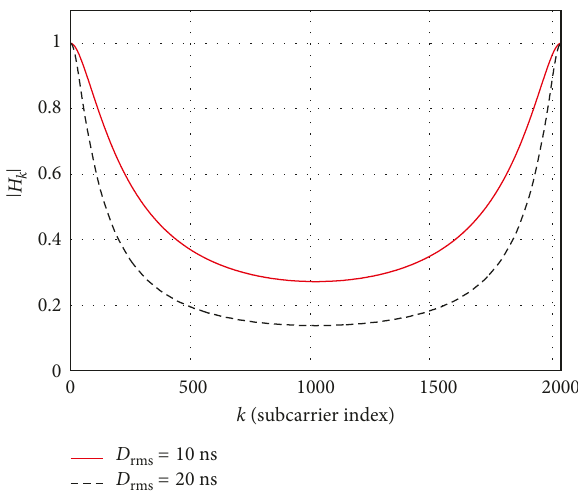
Figure 6: Frequency domain subcarrier gain for CIR with D , 20 ns. rms (cid:29) 10